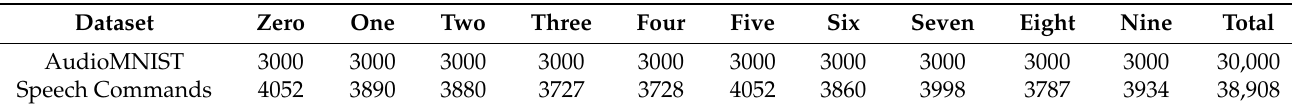
Table 2. A summary of